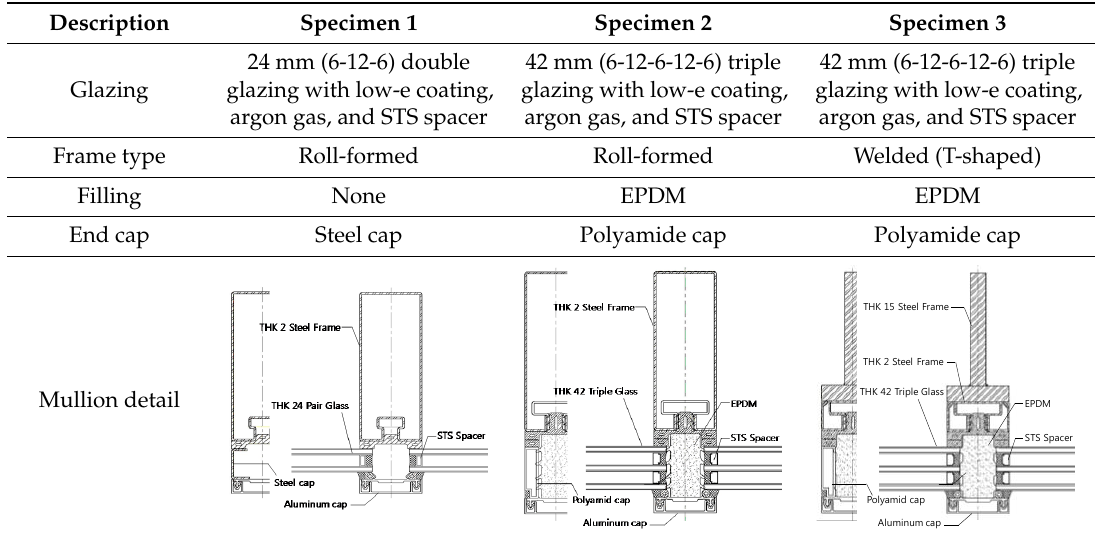
Table 2. Specification of the test specimens for validation.